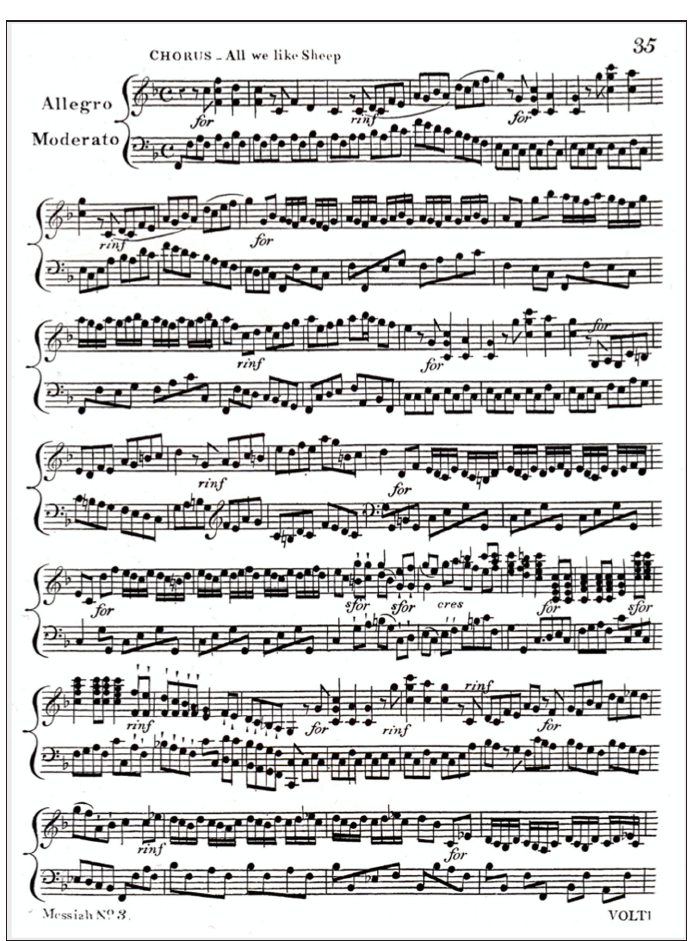
Fig. 2 : G. F. Handel, Pianoforte arrangement of ‘All we like sheep’ from Messiah , by Joseph Mazzinghi, 1802. Professor Donald